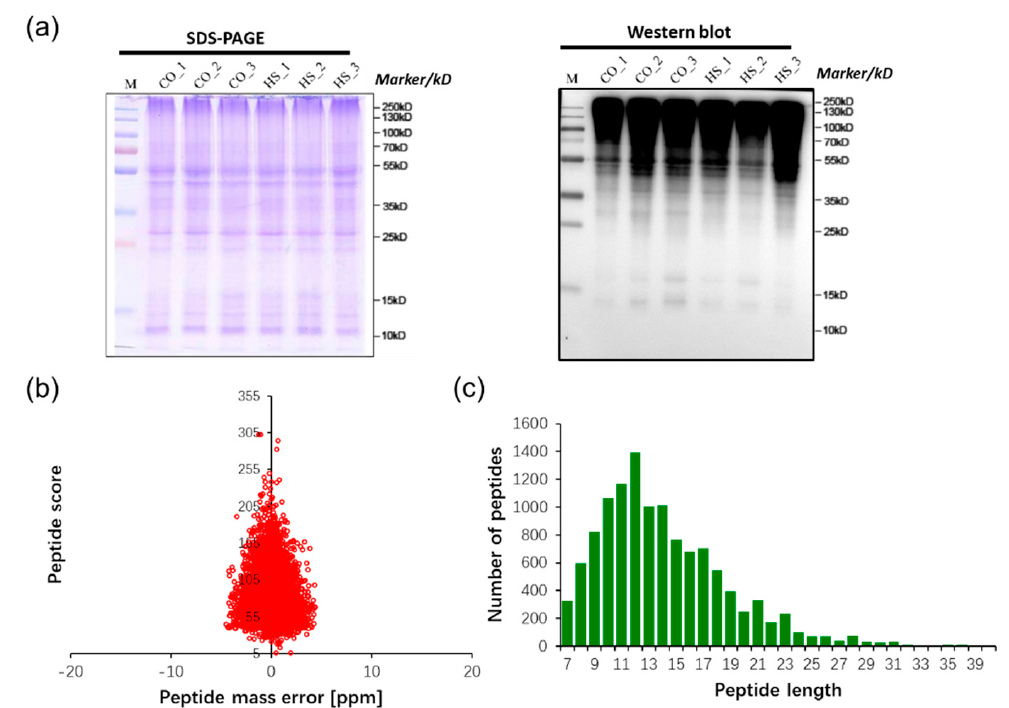
Figure 1. Proteomic identification of ubiquitinated peptides in Saccharina japonica . ( a ) Sodium dodecyl sulfate polyacrylamide gel electrophoresis (SDS-PAGE) and Western blot analysis using an anti-ubiquitin antibody. ( b ) Mass error distribution of all identified peptides by normal and heat stress. ( c ) Peptide length distribution.